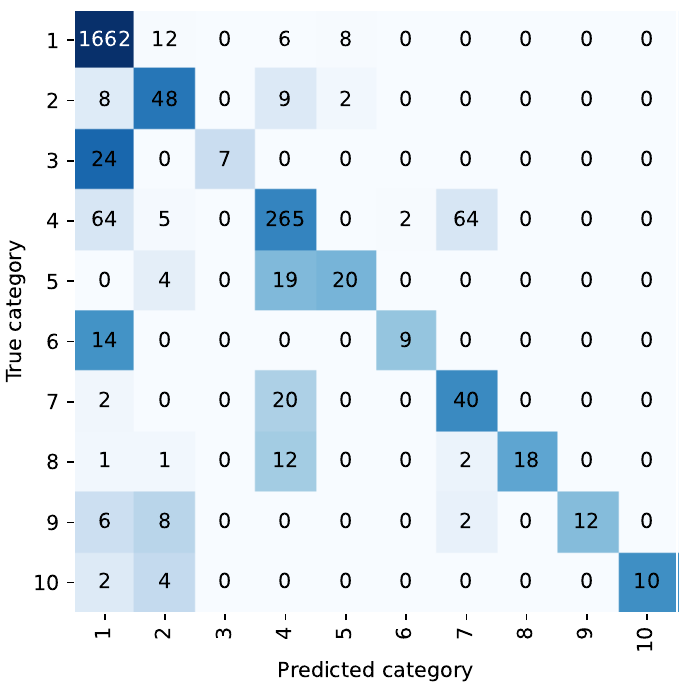
Figure 4. Confusion matrix of TP